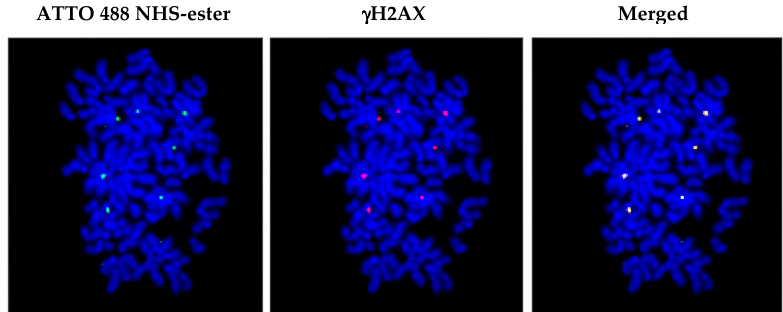
Figure 3. Genomic integration of cfCh in NIH3T3 cells leads to DNA double-strand breaks. NIH3T3 cells were treated with cfCh isolated from sera of cancer patients, labelled in their histones with ATTO 488 NHS-ester (ATTO-TEC GmbH, Germany. Catalogue No. AD 488-35) and applied to NIH3T3 cells. After several passages, metaphase spreads were prepared and immune-stained with antibody to γ H2AX. Co-localization of green (cfCh) and red ( γ H2AX) signals are clearly seen under florescent microscopy. Magnification x60. Reproduced from [64].